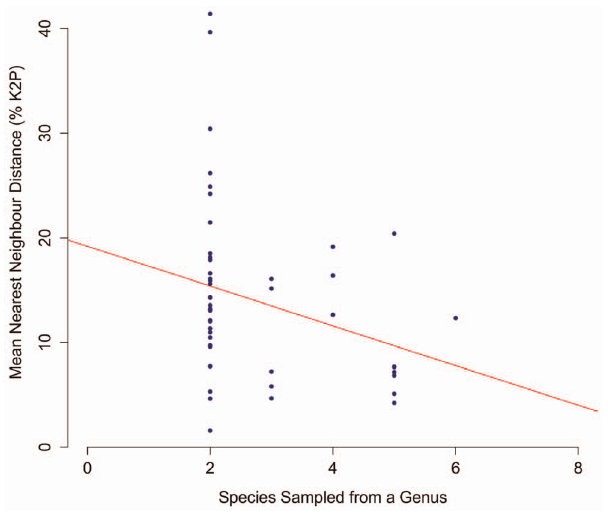
Figure 2. The barcode gap. Maximum intraspecific divergence (% K2P) in the barcode region of cytochrome c oxidase subunit I plotted against nearest neighbour distance (% K2P) for the 227 morphospecies examined in this study. Points above the line indicate species with a barcode gap. doi:10.1371/journal.pone.0095003.g002 (Figure 3; P =0.72, P= 0.38). Mean nearest neighbour distance appeared to decrease with the number of species analyzed from a genus, but the regression was not significant (Figure 4; P= 0.052). However, mean nearest neighbour distance did not significantly differ with sampling completeness within genera (Figure 5; P =0.77). Eleven species demonstrated intraspecific divergences greater than 2%. Neighbour-joining trees (K2P) and locality information are provided for eight of these cases (data for Hiatella